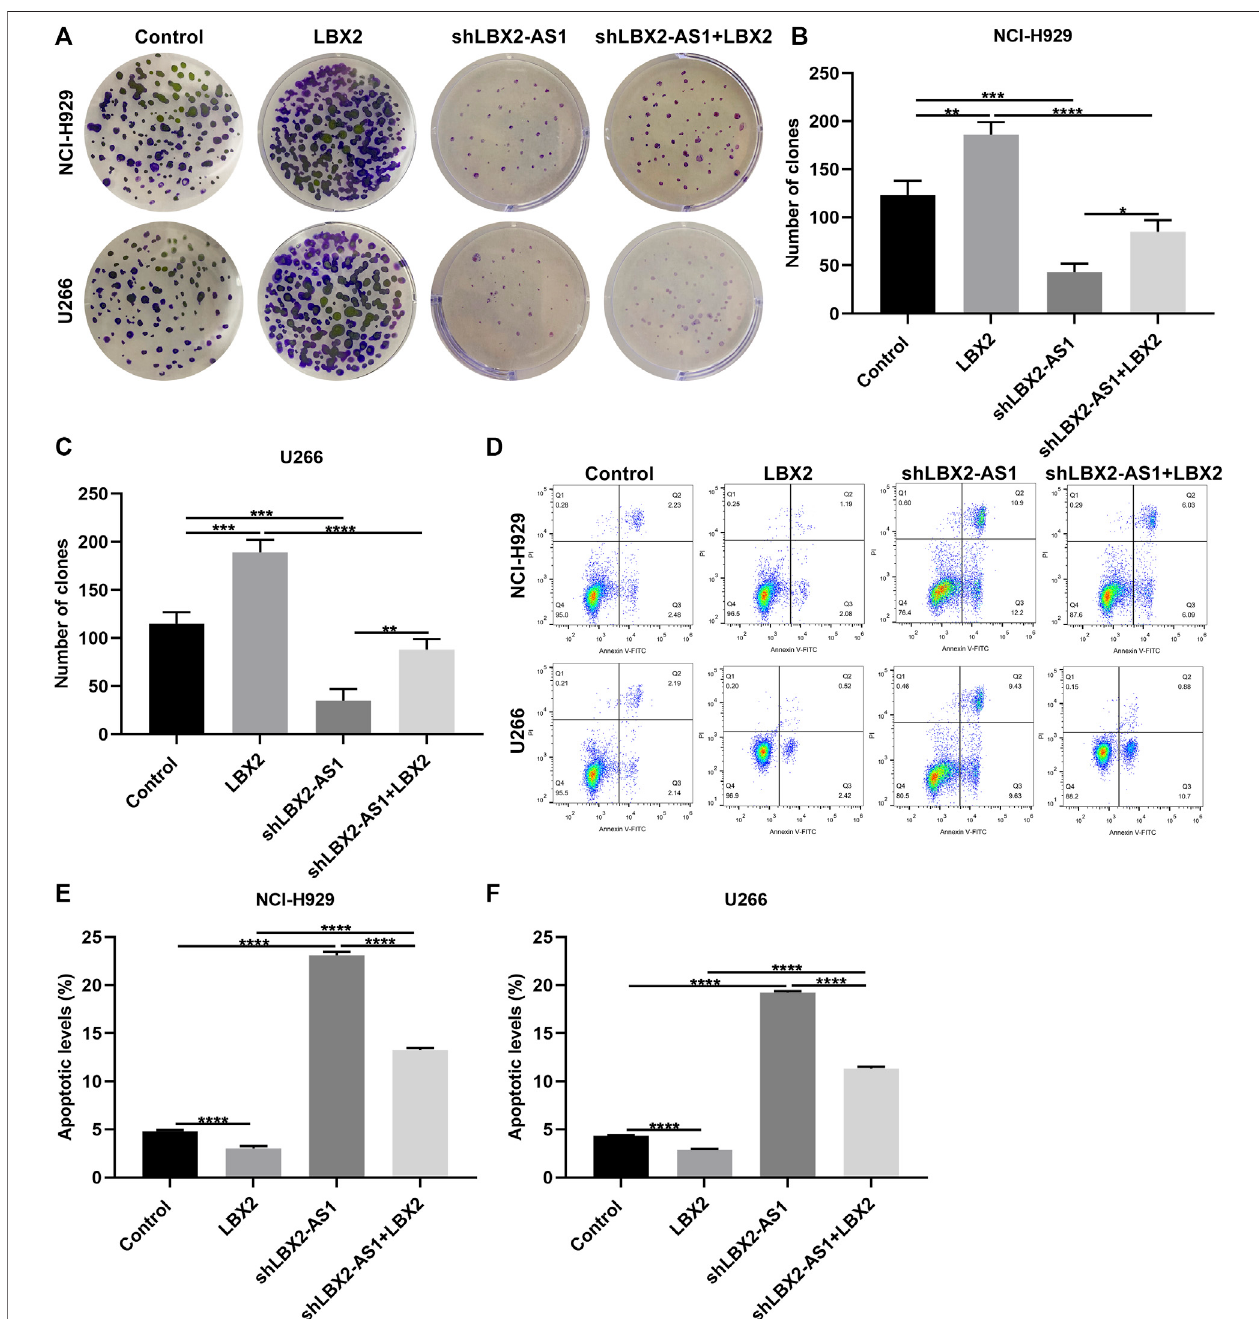
FIGURE 7 | LBX2-AS1 enhances proliferative ability and decreases apoptotic levels in MM cells through enhancing mRNA stability of LBX2. (A – C) The number of clones of NCI-H929 and U266 cells under transfection by pcDNA3.1-LBX2 and/or shLBX2-AS1. (D – F) Flow cytometry for the apoptotic rates of MM cells under transfection by pcDNA3.1-LBX2 and/or shLBX2-AS1. * p < 0.05; ** p < 0.01; *** p < 0.001; **** p < 0.0001.